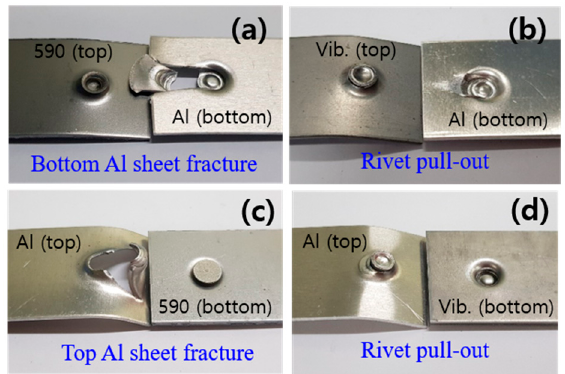
Figure 17. Comparison of failure modes of the SPR joint (fabricated by type A1 die) for different stack-up combinations. ( a ) SPFC590DP (top) and Al5052-H32 (bottom), ( b ) vibration-damping steel (top) and Al5052-H32 (bottom), ( c ) Al5052-H32 (top) and SPFC590DP (bottom), and ( d ) Al5052-H32 (top) and vibration-damping steel (bottom).